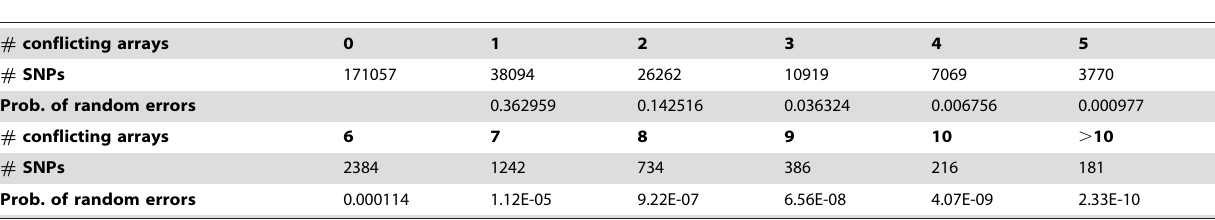
Table 1. Results for genotype conflicting analysis for 35